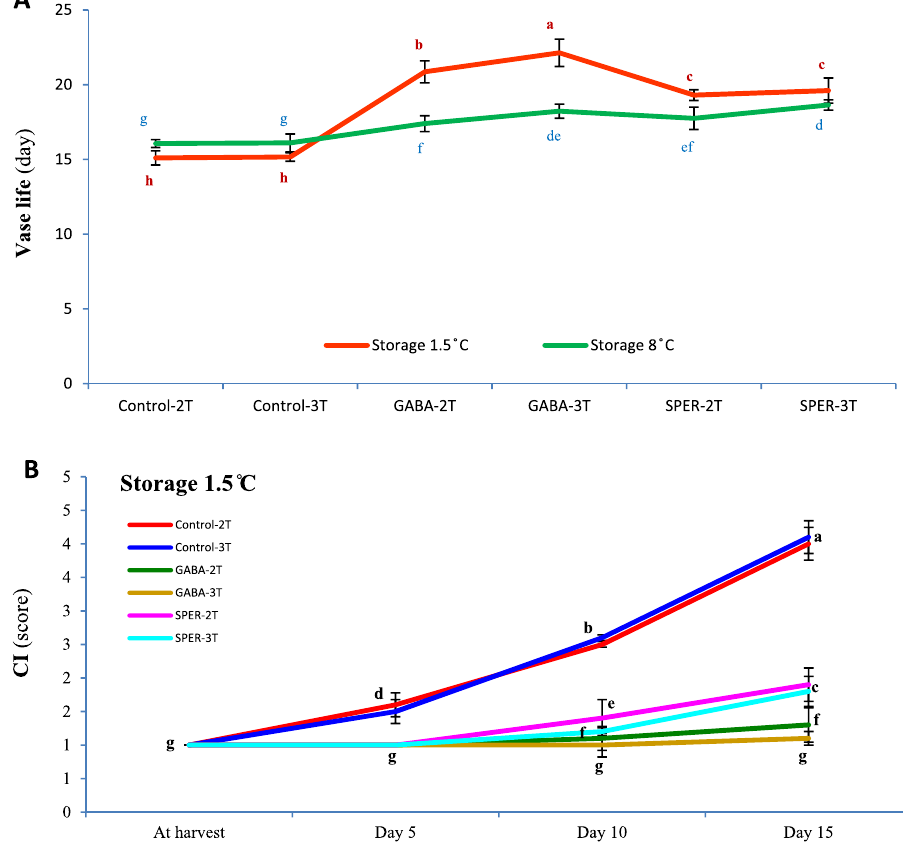
Figure 1. Vase life of the gerbera ‘Stanza’ cut flowers pre-harvest treated with GABA and SPER during cold storage at 1.5 °C and 8 °C ( A ). Chilling injury (CI) in gerbera ‘Stanza’ cut flowers pre-harvest treated with GABA and SPER ( B ). 2 T and 3 T represent number of times the GABA and SPER are sprayed on intact gerbera plants at pre-harvest. Values are mean SE, n = 4. The bars marked with the same letters are not significantly different at p <